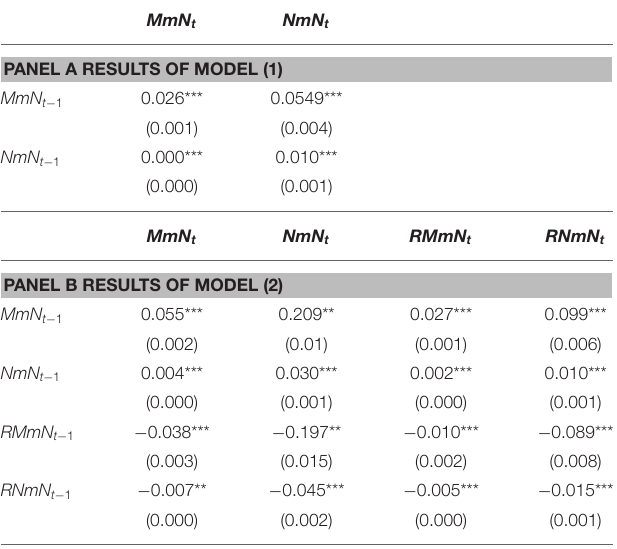
TABLE 9 | Results of panel vector autoregression (VAR) model for main-media